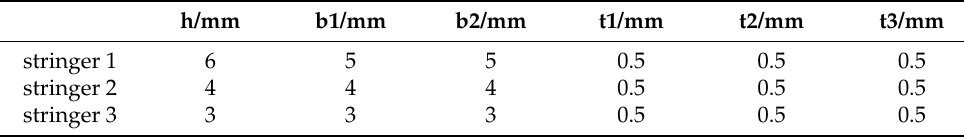
Table 5. Constraints of structure optimization.